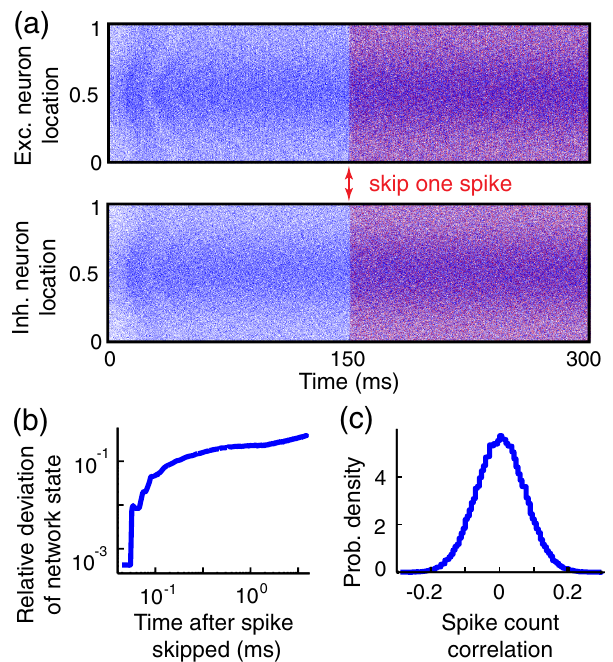
FIG. 2. Balanced network dynamics. (a) Raster plots from two Monte Carlo simulations with identical initial states (blue and red dots, respectively). In one simulation (red dots), the first spike after 150 ms is skipped, revealing a sensitivity to perturbations. (b) The normalized L 2 deviation between the vector of membrane potentials of the two network simulations from (a) as a function of time elapsed since a spike was skipped. (c) Histogram of spike count correlations between neighboring neurons (mean of 4 . 84 × 10 − 4 and standard deviation of 0.0711). Correlations computed by counting spikes over a 300 ms window in each neuron from 200 simulations of the same network realization with different initial conditions. All panels from network simulations with N ¼ 10 5 neurons.